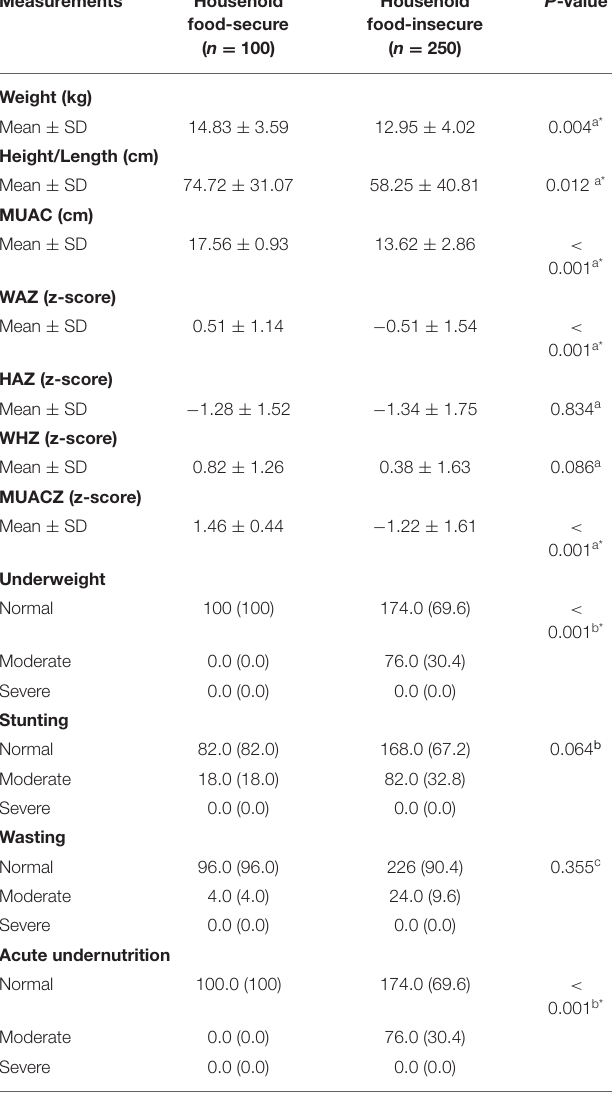
TABLE 2 | Nutritional status and anthropometric measurements of under-five children by household food-security status ( n = 350). Measurements